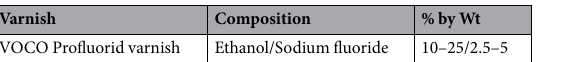
Table 1. Product composition according material safety data sheets